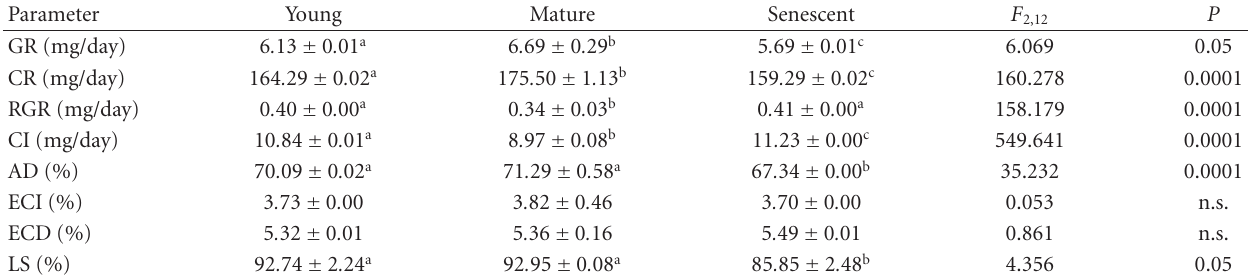
Table 5: Food utilization e ffi ciency measures of fourth instar larva of D. casignetum reared on young, mature, and senescent sunflower